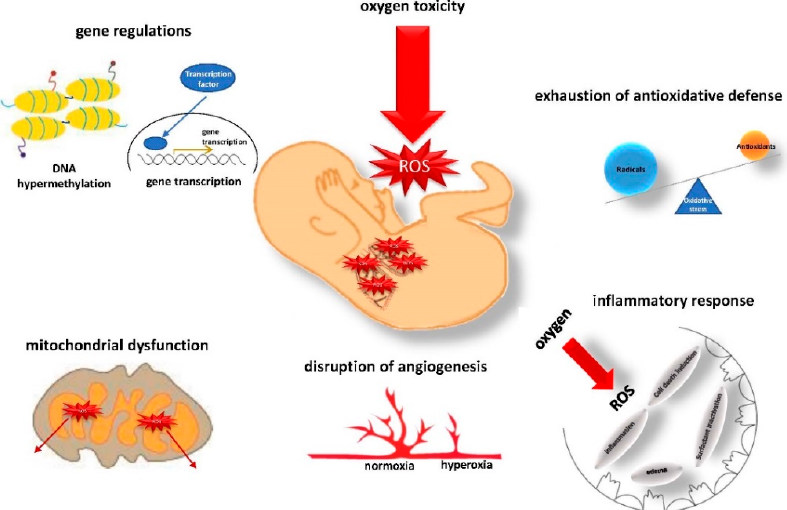
Figure 1. ROS production and downstream pathologies in the immature lung. After birth, the preterm infant and its lungs are exposed to a relatively hyperoxic environment compared to the intrauterine situation. ROS induce alterations in gene regulation and mitochondrial function, along with disruption of further pulmonary vasculogenesis and an inflammatory response causing damage to the immature lung. The excess ROS production is aggravated by restricted antioxidative defense mechanisms, resulting in acute and long-term injuries and insults to the lung and further lung development.